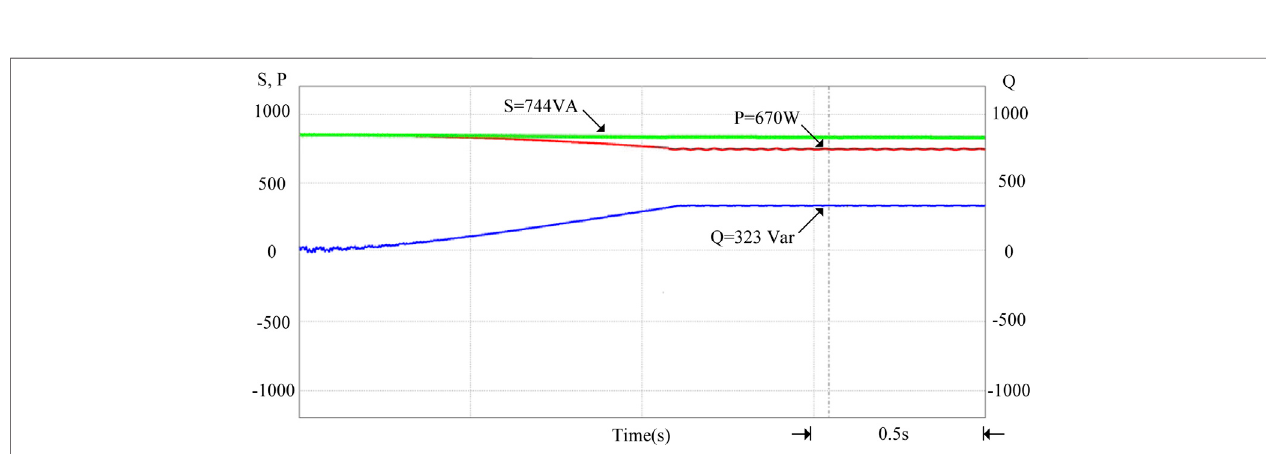
FIGURE 13 | When the grid voltage per unit value is between 1 and 1.03 p.u., the active output power and reactive power control situation of the smart inverter.